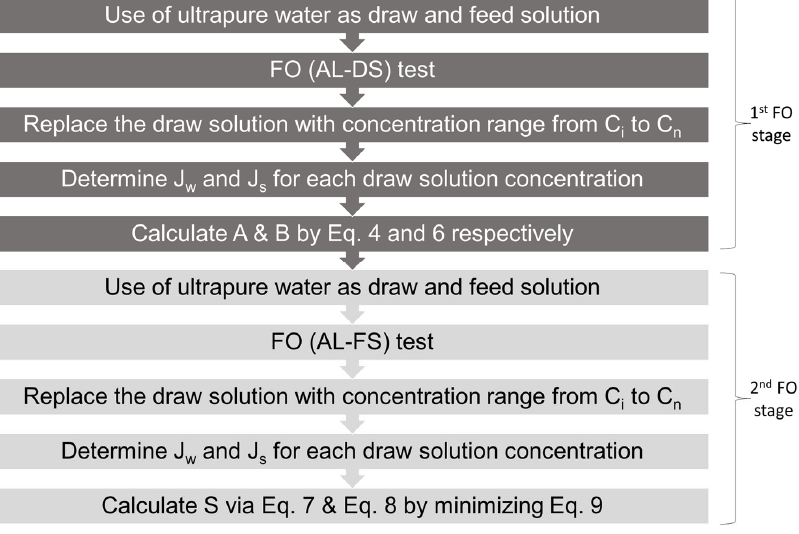
Figure 2. Flow chart of the two ‐ stage non ‐ pressurized method.